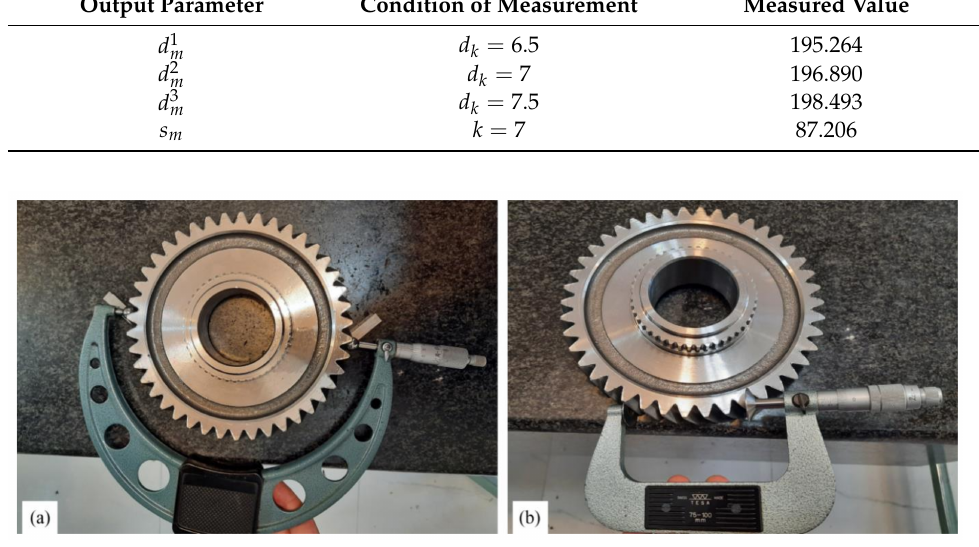
Figure 9. Measuring of over two balls and span size.